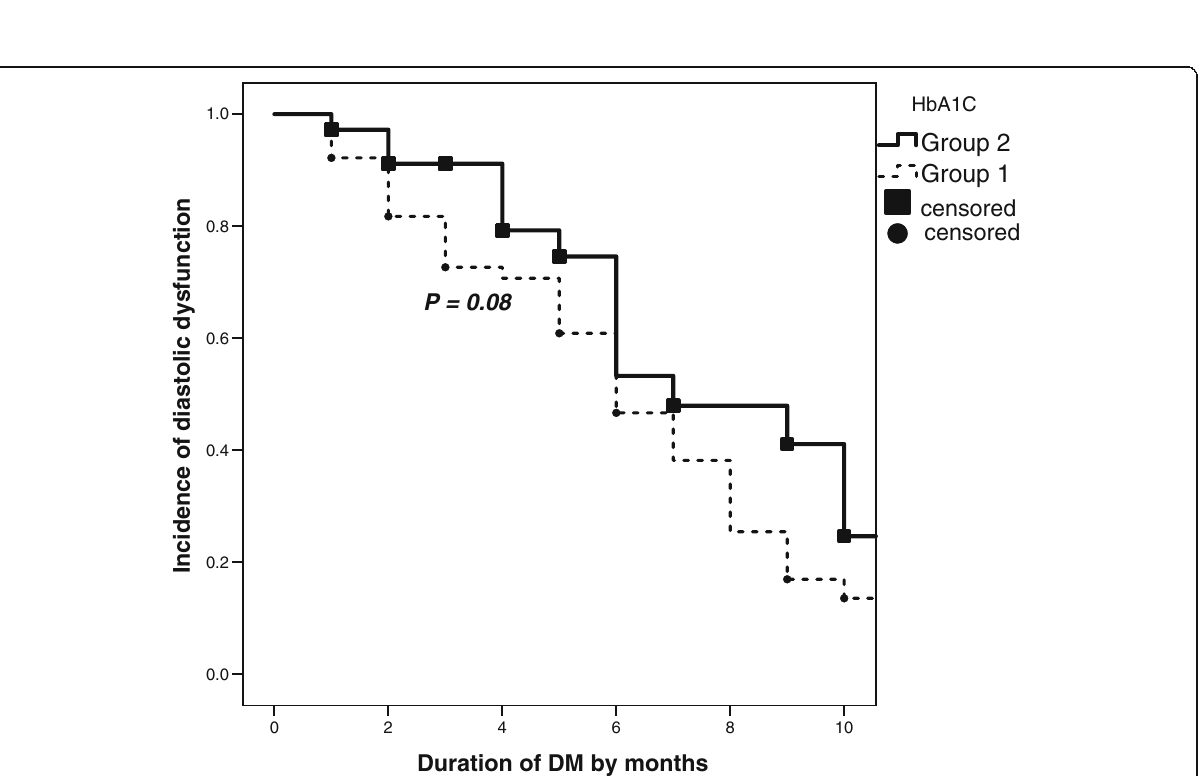
Fig. 3 Kaplan Meier survival curve showing time to diagnosis of diastolic dysfunction within 12 months of DM